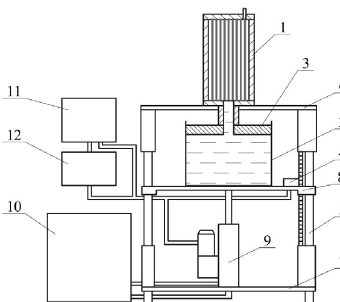
Fig. 1. Scheme of the experimental bench: 1 – mold; 2 – squeezing chamber; 3 – press piston; 4 – displacement sensor; 5 – guides; 6, 7 – mounting plate; 8 – movable plate; 9 – hydraulic cylinder; 10 – pump unit; 11 – operational control system; 12 – control unit of step